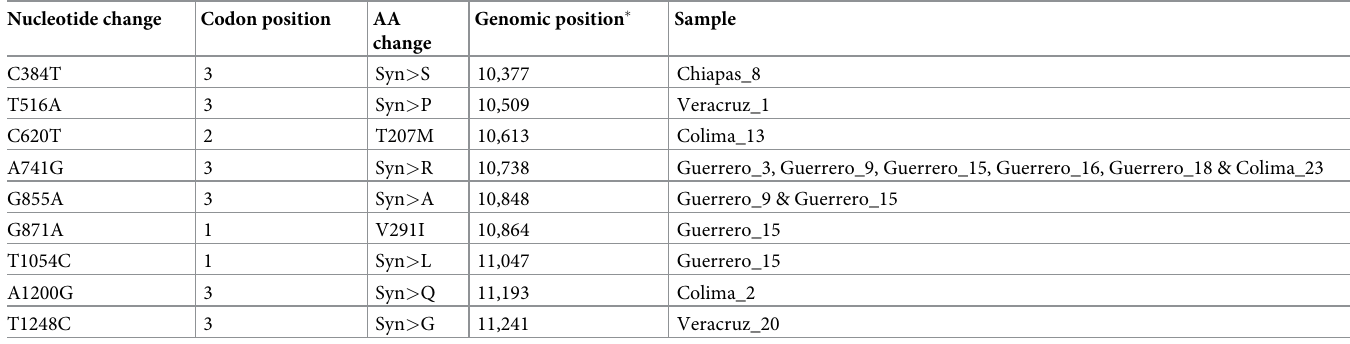
Table 1. Mutations in partial CHIKV E1 consensus sequences from Mexican